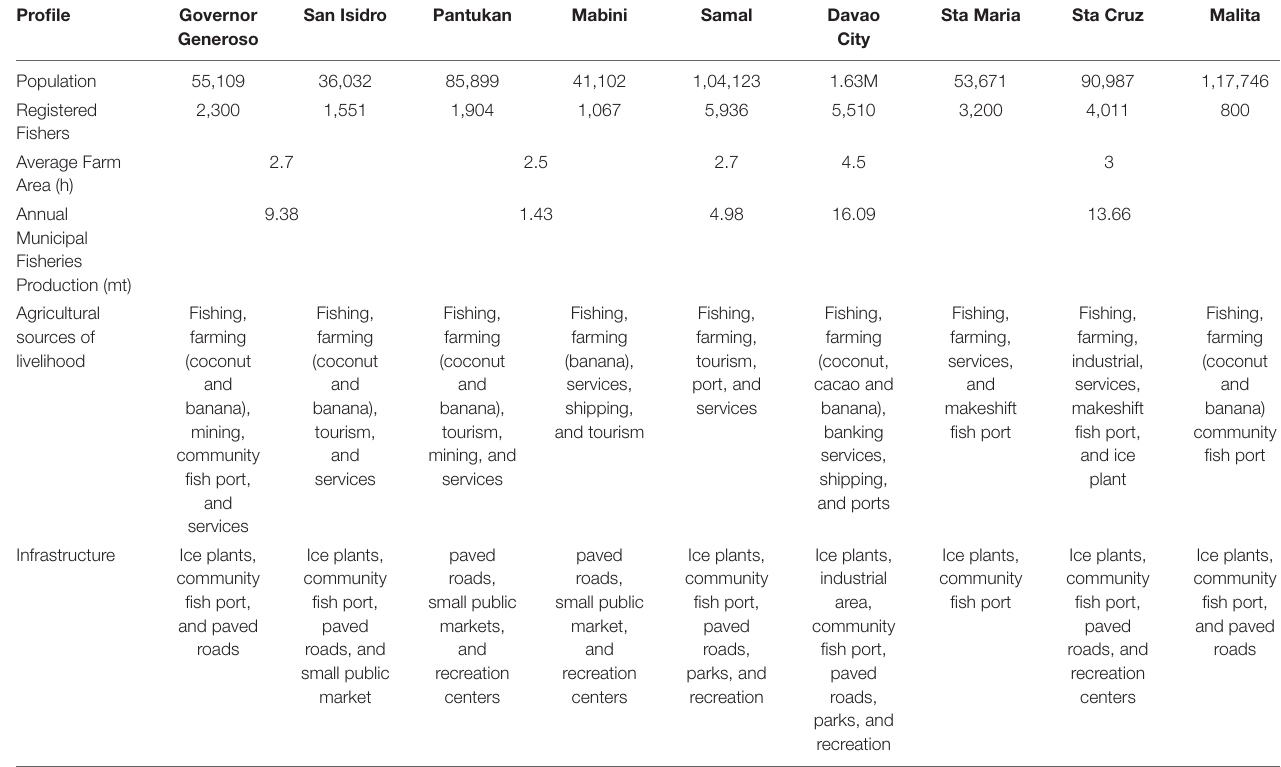
TABLE 1 | Number of population and registered fishers and their livelihood in the various study sites around Davao Gulf.